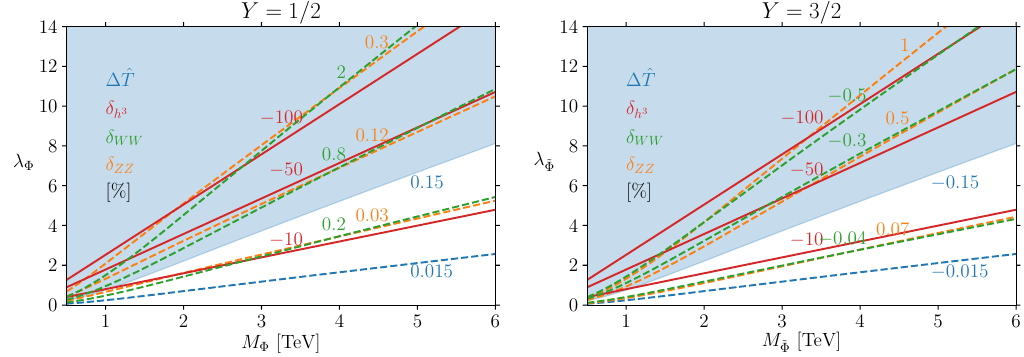
Figure 2 . Parameter space of the scalar weak quadruplet models with Y = 1 / 2 (left) and Y = 3 / 2